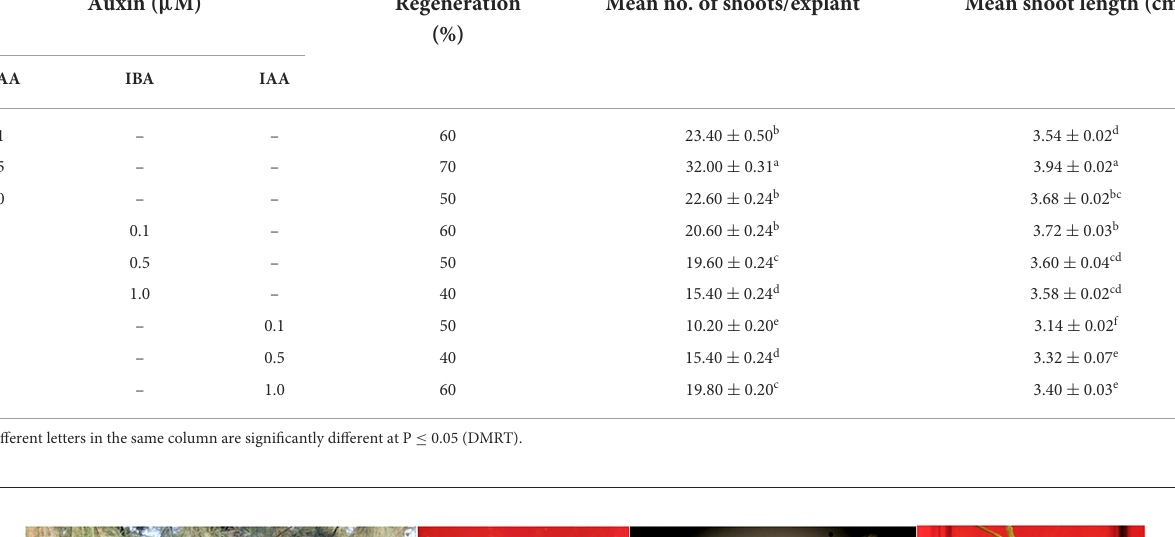
TABLE 3 Adventitious microshoots formation (means ± SE) on optimized cytokinin with different auxins (8 weeks after culture). Auxin ( µ M) Regeneration